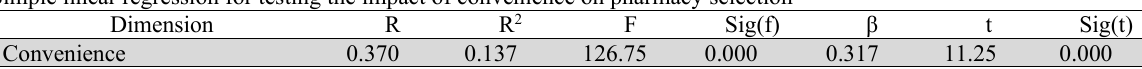
Simple linear regression for testing the impact of convenience on pharmacy selection